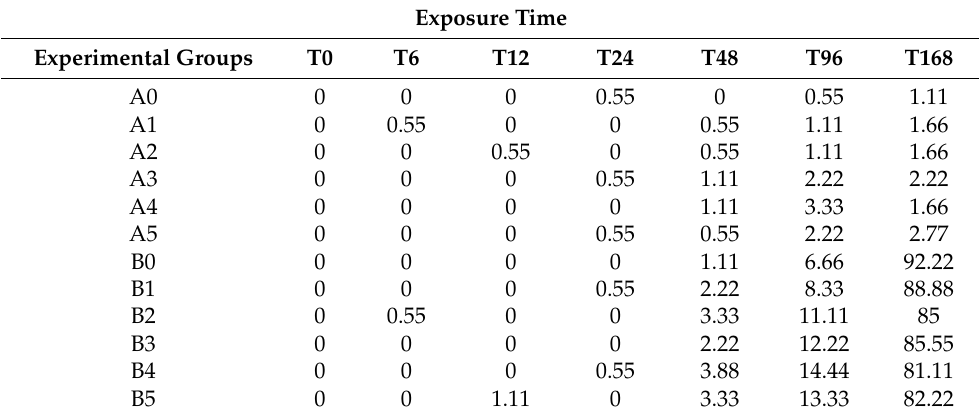
Table 3. Artemia salina mortality rate (%) calculated for the experimental Group A and B. Experimental Groups Exposure Time